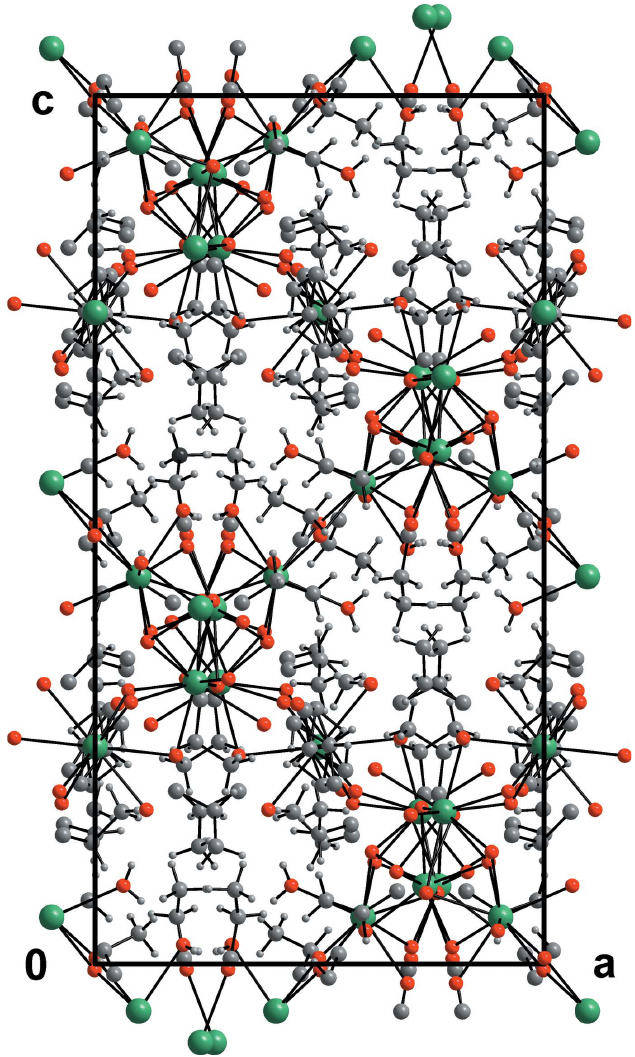
Figure 1 A view of the crystal structure along the b axis. Ba, O, C and water H atoms are shown as green, red, dark gray and tiny gray spheres, respectively.